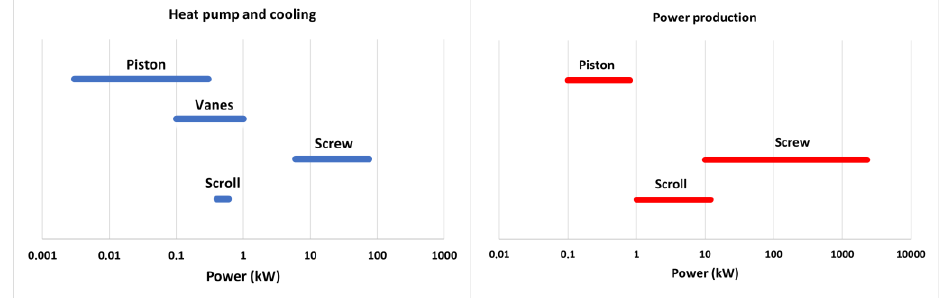
Figure 22. Power output for different expansion devices under two-phase conditions, showing heat pump and cooling ( left ), and power production ( right ).